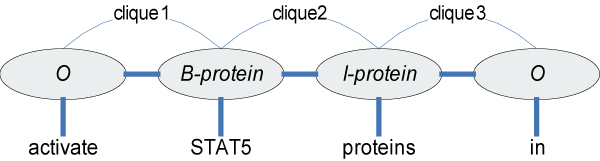
Graphical representation of "activate STAT5 proteins in" tagged as "[O, B-protein, I-protein, O]".